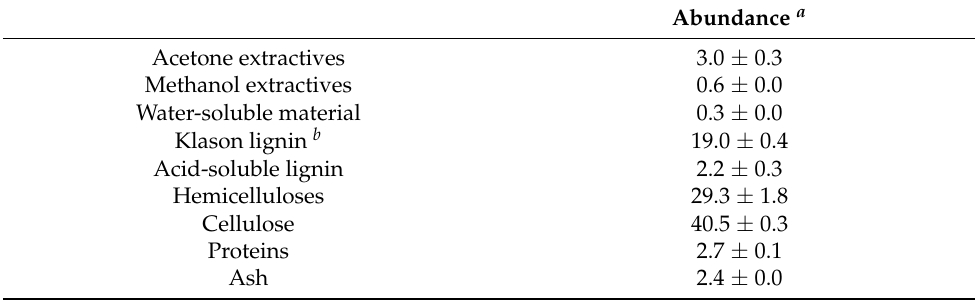
Table 1. Abundance (in percentage) of the main constituents of OTP residue (dry